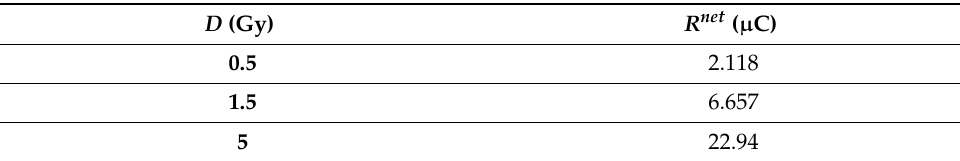
Table 2. Measured net values for each dose point when TLDs were exposed to Cesium-137. Relative uncertainties on R net are expressed in Table 4.